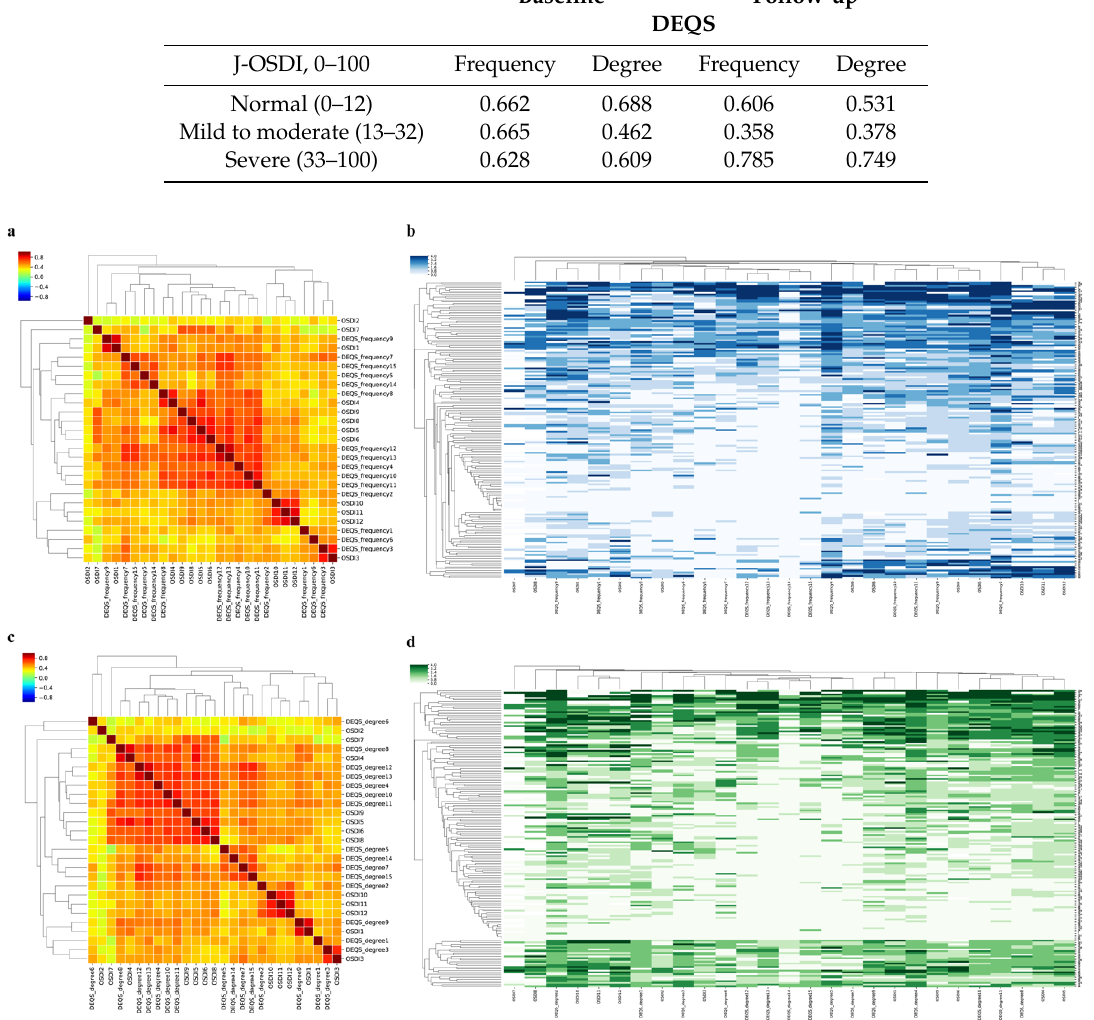
Figure 2. Correlation between the J-OSDI and DEQS at the baseline visit. Pearson’s correlation coefficients and scores between the J-OSDI and DEQS are shown in the heatmap as a color gradient. ( a ) Heatmap of the correlation between the J-OSDI and DEQS (Frequency) at the baseline visit. ( b ) Heatmap with clustering of the J-OSDI score and DEQS (Frequency) in all participants. ( c ) Heatmap of the correlation between the J-OSDI score and DEQS (Degree) at the baseline visit. ( d ) Heatmap with clustering of the J-OSDI score and DEQS (Degree) in all participants. Color scale bars: Correlation coefficients ( a , c ) and the 5-point scale for each question scores ( b , d ). Axis: each question from the OSDI and DEQS.